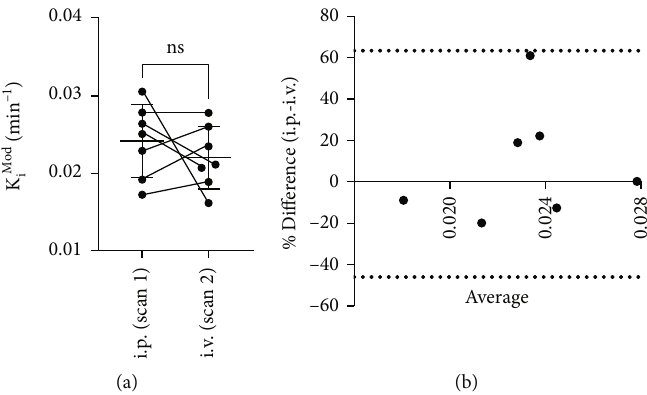
K Figure 3: Within-animal comparison of K i Mod outcome values. (a) i Mod calculated using 15-120min of the TAC and extended Patlak analysis. Values are mean ± S : D : ; N = 7 ; ns: not signi fi cant, paired two-tailed t -test. (b) Comparison of K i Mod outcome values using a Bland-Altman plot to estimate bias. Dotted lines indicate the 95% limits of